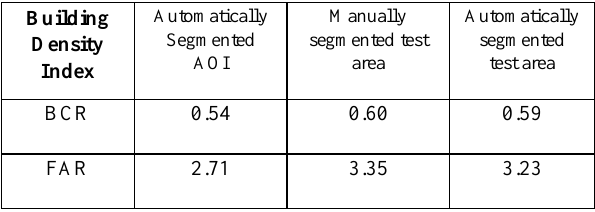
Table1. BCR and FAR indicators on AOI and test